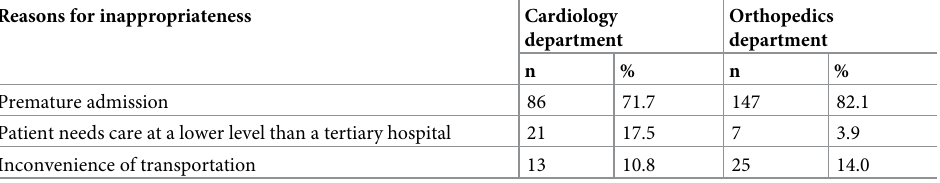
Table 4. Reasons for inappropriate